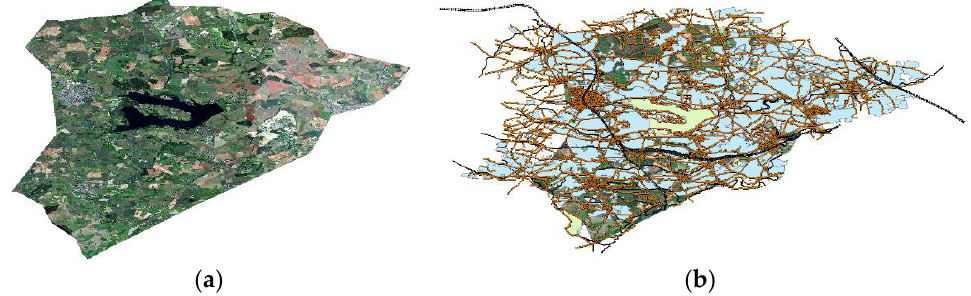
Figure 6. Map of Rutland, England: ( a ) satellite map data in Rutland; ( b ) OSM map in Rutland.